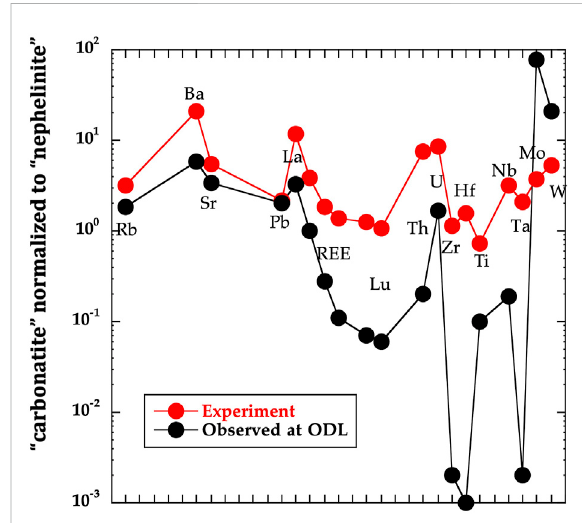
FIGURE 10 Ratio of “ natrocarbonatite concentrations ” to “ nephelinite concentrations ” for the spidergram of trace elements given. For “ observed at ODL ” we have used the 2005 natrocarbonatite and 2008 ODL-5 nephelinite. In the case of the ODL-5wk experiment, we have take sub-sample concentration average of the lower two sub-samples divided by the average of the upper six subsamples (nephelinite mush). A general similarity of behavior is evident based on the pattern reproduction. Certain high fi eld strength elements poorly match, re fl ecting the fact that abundant clinopyroxene and garnet (which hold these elements) still exist within this “ natrocarbonatite ” sub-sample (see